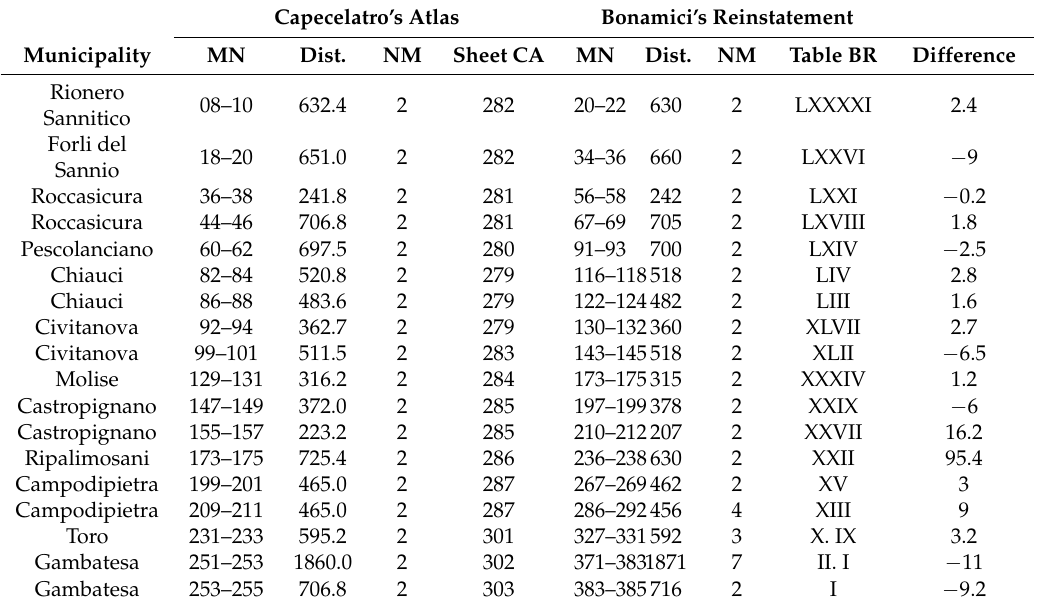
Table 4. Inter-milestones distances in meters (Dist.), proceeding from N to S along the Tratturo Castel di Sangro-Lucera, in the Capecelatro’s Atlas and the Bonamici’s reinstatement. The table reports also the milestone numbers (MN), the number of milestones comprises in the interval (NM), the Capecelatro’s Atlas sheet, the Bonamici’s reinstatement table, and the difference (in meters) between the distances calculated on the two data sets. Capecelatro’s